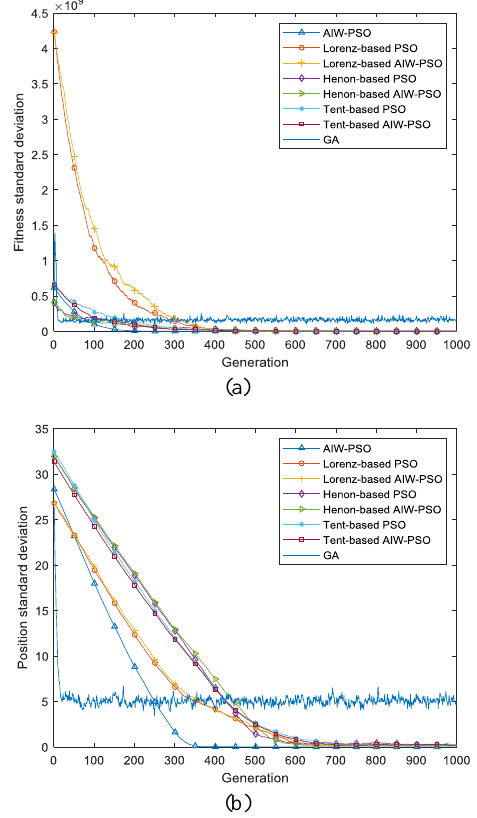
Figure 8. (a) Population fitness standard deviation (b) Population position standard deviation for different